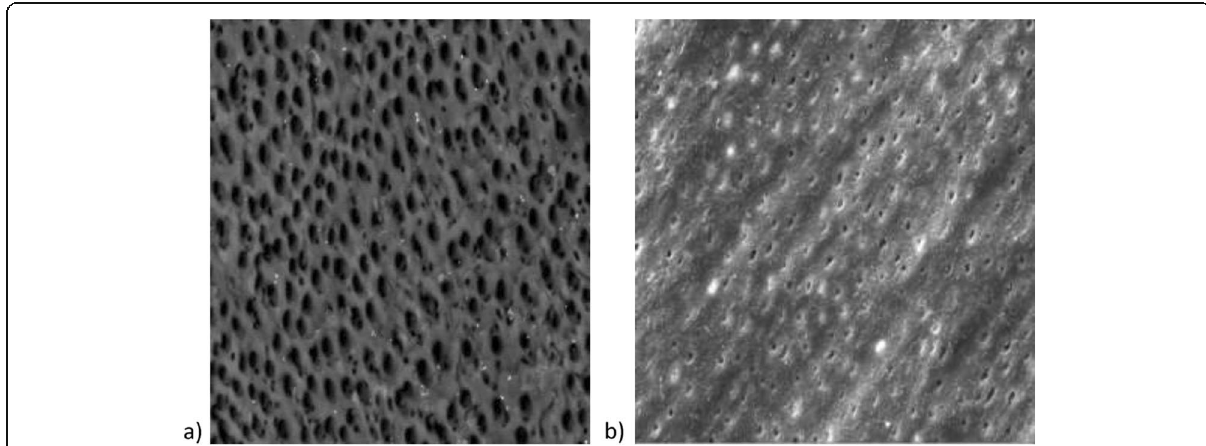
Fig. 1 Representative SEM image. a Showing opening of dentinal tubules. b Showing partial melting and fusion of tubule opening after application by diode laser (970 nm) at 40 s (a narrowing of the dentinal tubules) at × 1500